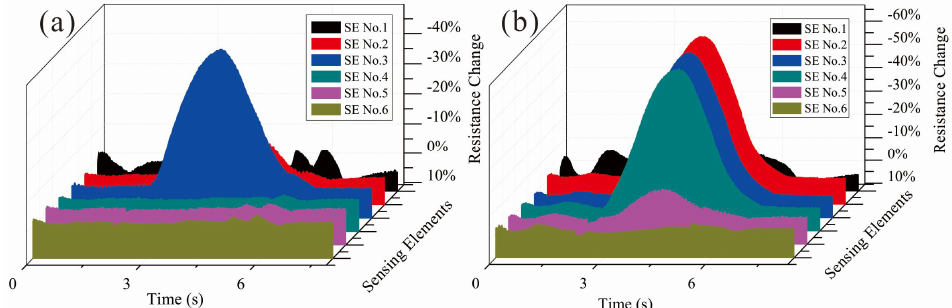
Figure 10. The results (filtered by 20 Hz low-pass) of indentation test with different contact disks on parallel SEs (CDoE is 1.0 mm): ( a ) 5 mm diameter; ( b ) 10 mm diameter.